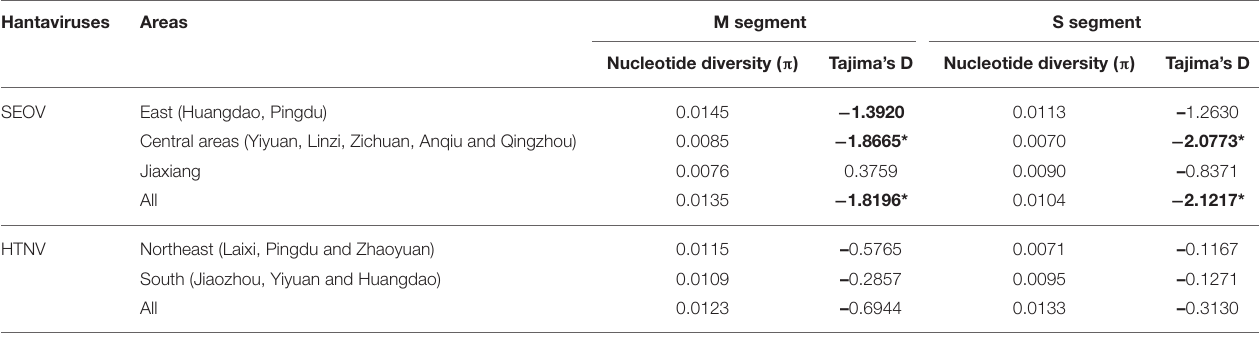
* Indicates significance at p < 0.05. Bold values indicate that some codons with multiple evolutionary paths were detected when Tajima’s D test was performed. SEOV, Seoul virus; HTNV, Hantaan